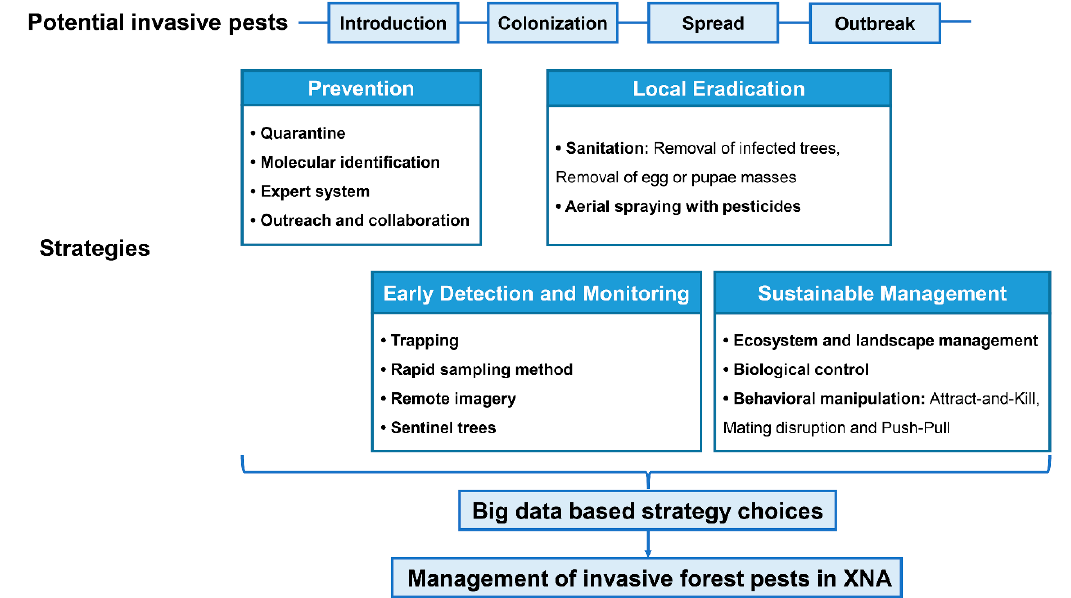
Figure 3. The framework of invasive pest management in Xiongan New Area (XNA). Four main strategies including prevention, early detection and monitoring, local eradication, and long-term sustainable containment implemented for different stages of the process of pest invasions. We also listed specific techniques for each of the strategies that can be selected based on a “big data”-based decision system to minimize the impacts of invasive pests in Xiongan New Area.